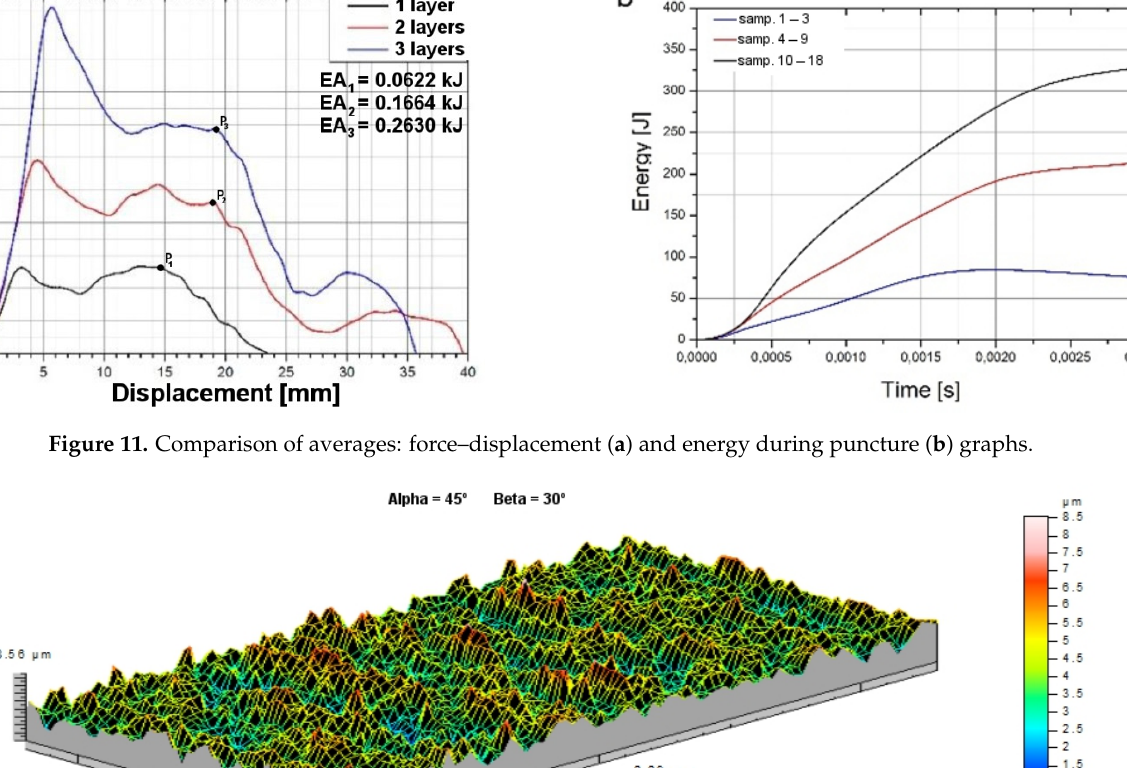
Figure 10. Force–displacement relations during puncture and energy during puncture charts for 1 plate ( a ), 2 plates ( b ), and 3 plates ( c ).